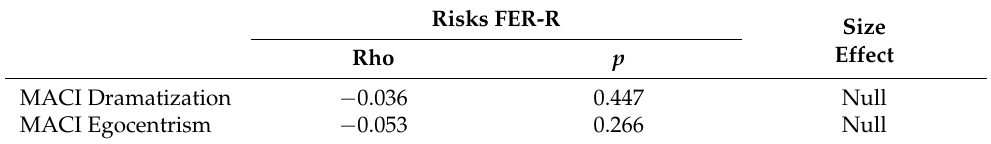
Table 4. Divergent validity. Spearman’s Rho correlations between total risks on the FER-R and dramatization and egocentrism on the MACI.